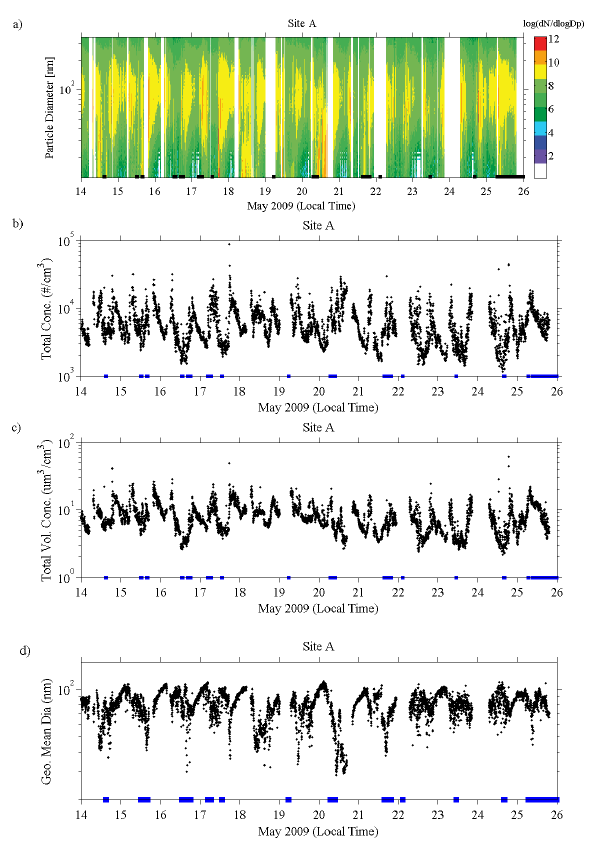
Fig. 4. Diurnal evolution of dry aerosol size distribution for Site B Figure 4: Diurnal evolution of dry air size distribution for Site B ( Besisahar) a) 2D dry size distribution, (Besisahar) (a) 2-D dry size distribution, (b) total number concen- b)Total number concentration [ 3 − cm ;c)Total volume concentration [ 33 − cmnm d) Geometric Mean tration [cm − 3 ]; (c) total volume concentration [nm 3 cm − 3 ]; (d) Ge- diameter [nm]. The discontinuities in the data are associated with electricity outages. The square dots ometric Mean diameter [nm]. The discontinuities in the data are (black/blue) on the bottom axis indicate precipitation events. associated with electricity outages. The square dots (black/blue) on the bottom axis indicate precipitation